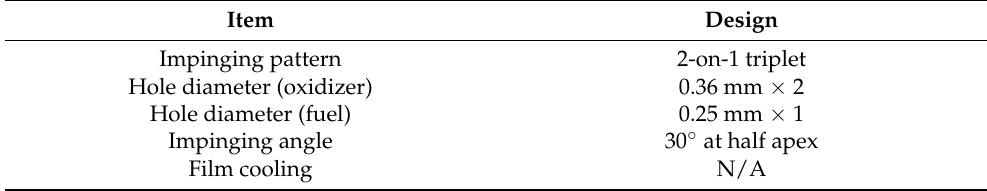
Figure 9. Shadowgraph images of injection spray by water (left: 0° angle, right: 90° angle). For the injector, the relational data of the injection differential pressure and mass flow rate were obtained in advance using actual fluid, and approximate equations were ob ‐ tained from the data by power ‐ law approximation, described as 𝑚(cid:4662) (cid:3404) 𝛼Δ𝑃 (cid:3081) . The results of the mass flow calibration of the fuel and oxidizer are shown in Figure 10. Here, each test condition was tested only one time. The results of calculating 𝛼 and 𝛽 in the ap ‐ proximate equation are shown in Table 5. The coefficients of determination R 2 for both equations were larger than 0.99, indicating that they were approximated with high accu ‐ racy.